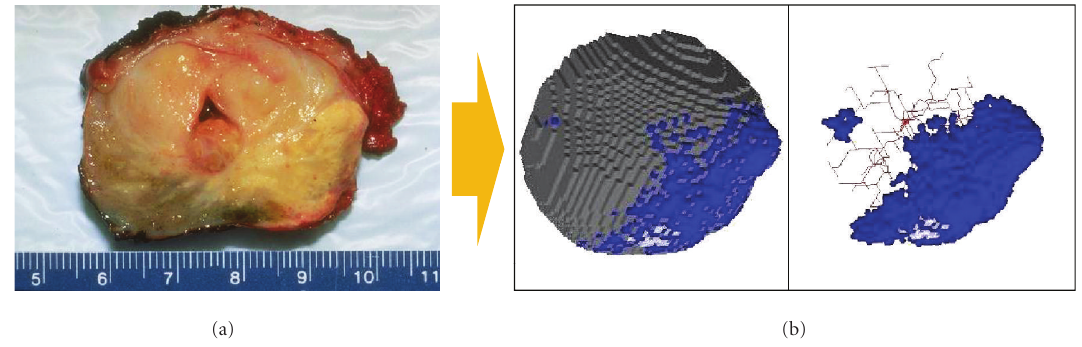
Figure 4: Cellular Automata. (a) Human prostate gland containing carcinoma at the lower right part, seen as a yellowish mass [23]. (b) Cellular automata named CancerSim [49] simulating tumor growth. Tumor cells are shown in blue, healthy tissue in gray, and blood vessels in red, dual view with and without healthy tissue. The three-dimensional shape of the prostate gland and the simulated structure can be compared to improve the model and to explain the observed